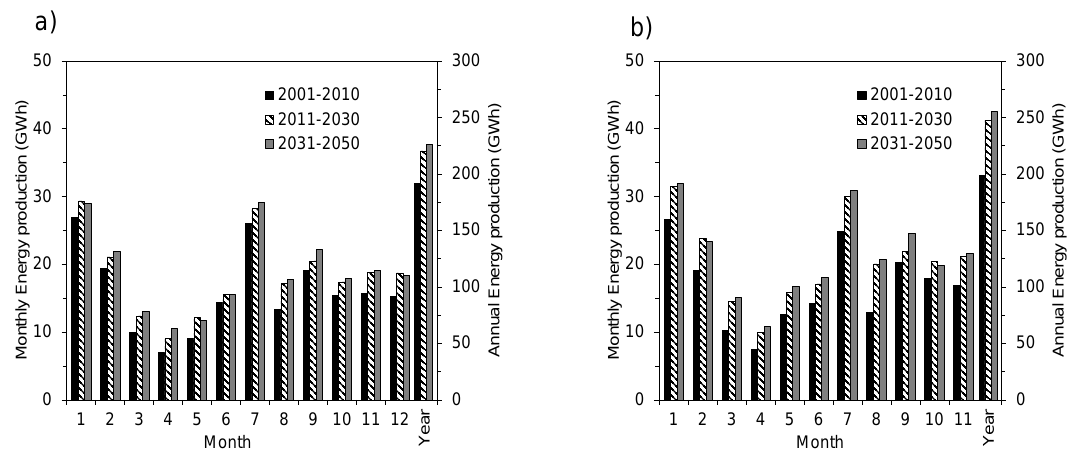
Figure 8. Average monthly and annual reservoir hydropower production evaluated by the hydropower simulation model using the discharge dataset built starting from ( a ) REMO and ( b ) RegCM3 climatic scenarios.